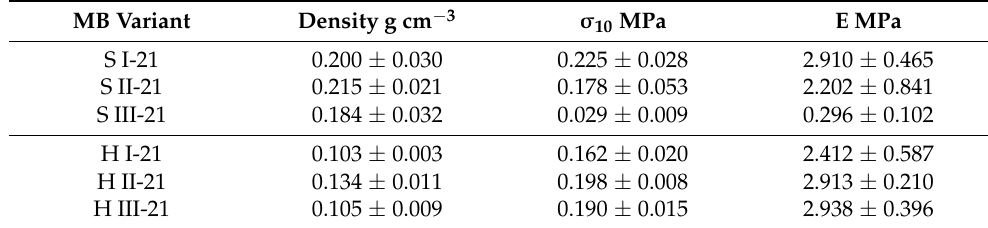
Table 5. Compressive properties of mycelium biocomposites (MB) after 21 day